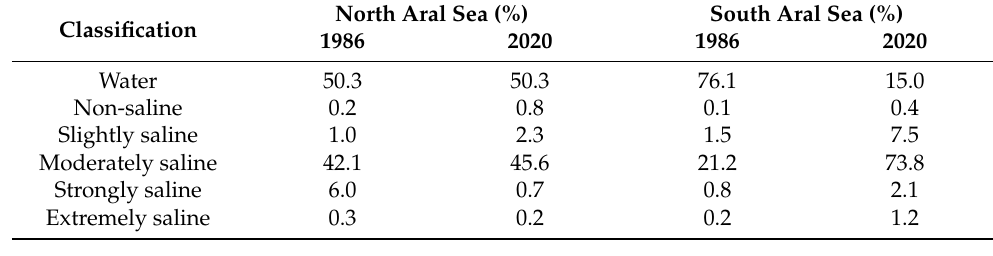
Table 4. The area percentage of salinization type transformation from 1986 to 2020.